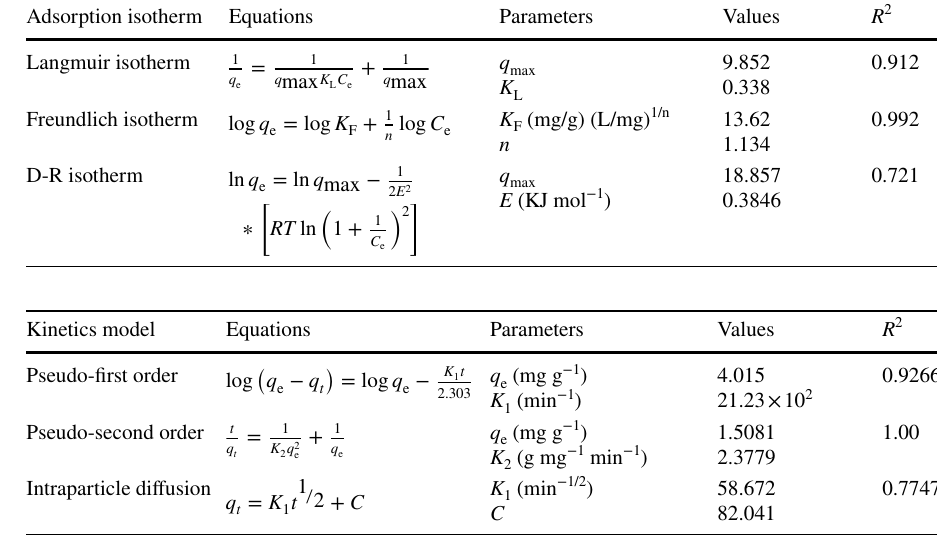
Table 1 Isotherm data for Cr(VI) adsorption using human hair